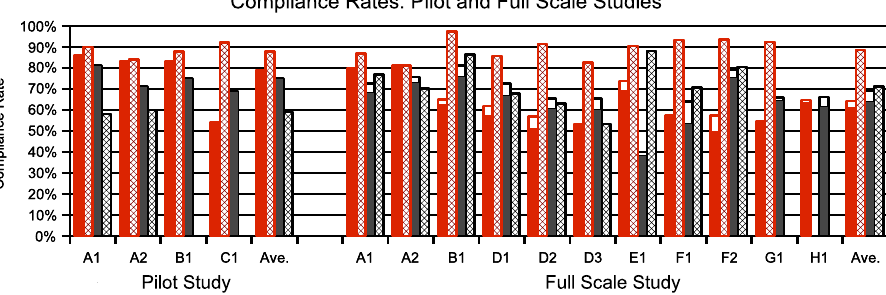
FIG. 1. (cid:1) Color online (cid:2) Compliance rates in the pilot and full-scale study, broken down by individual classes and the average rate for each study. The four bars in each group are, left to right, the web-based precourse assessment, the paper-based precourse assessment, the web-based postcourse assessment, and the paper-based postcourse assessment. Shown are the compliance rates on each of the paper and web assessments, and the average for each of the studies. On the full-scale study, the small white bars on top of the web-based assessment represent the rates of students who attempted but did not complete